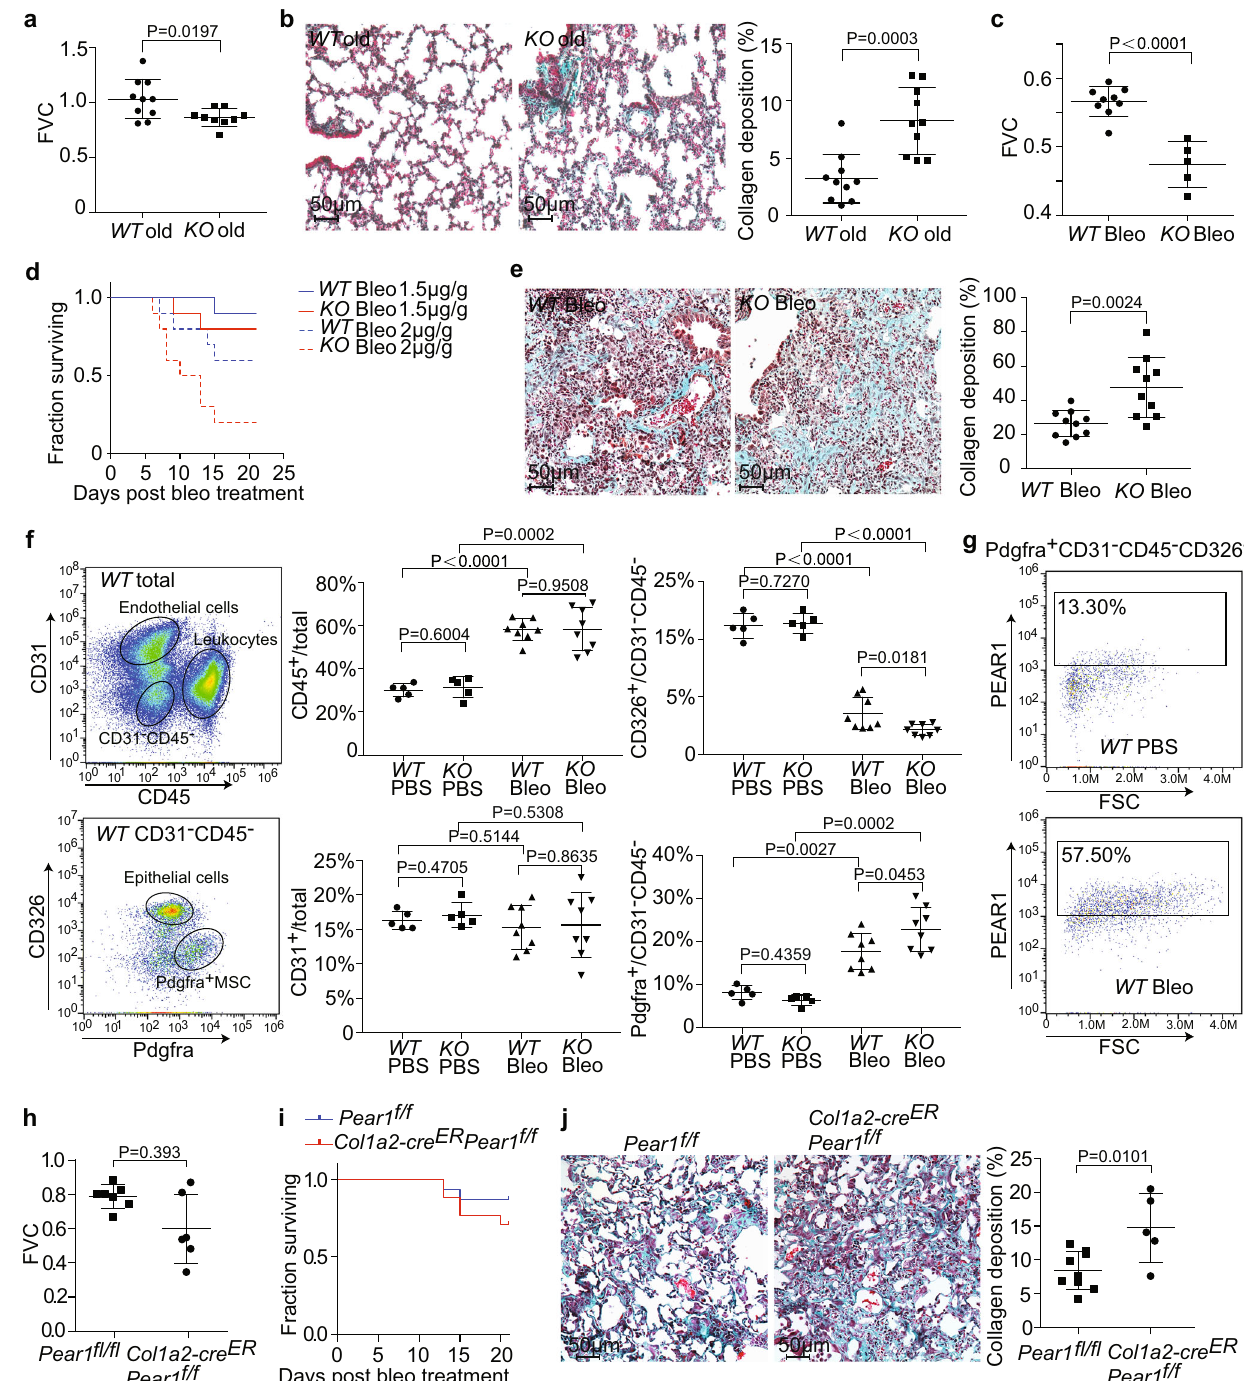
fi brosis, and TGF β signaling (Fig. 2g). We further identi fi ed a set of differentially expressed genes (DEGs) in active fi broblast between Pear1 − / − bleo and WT bleo (Fig. 2h). In concordance with the elevated level of α -smooth muscle actin in Fibromyocytes, markers of Cluster 4 in Pear1 − / − bleo were enriched in contractile function and focal adhesion (Supplementary Fig. 8a, b). Cluster 0 was the largest cell cluster in the WT ctrl and Pear1 − / − ctrl, but was diminished after bleo treatment (Fig. 2c, Supplementary Fig. 4). The markersof Cluster 0 in WT ctrl were enriched in pathways involved in cellular response to growth factor stimulus and wound healing (Supplementary Fig. 8c, d).